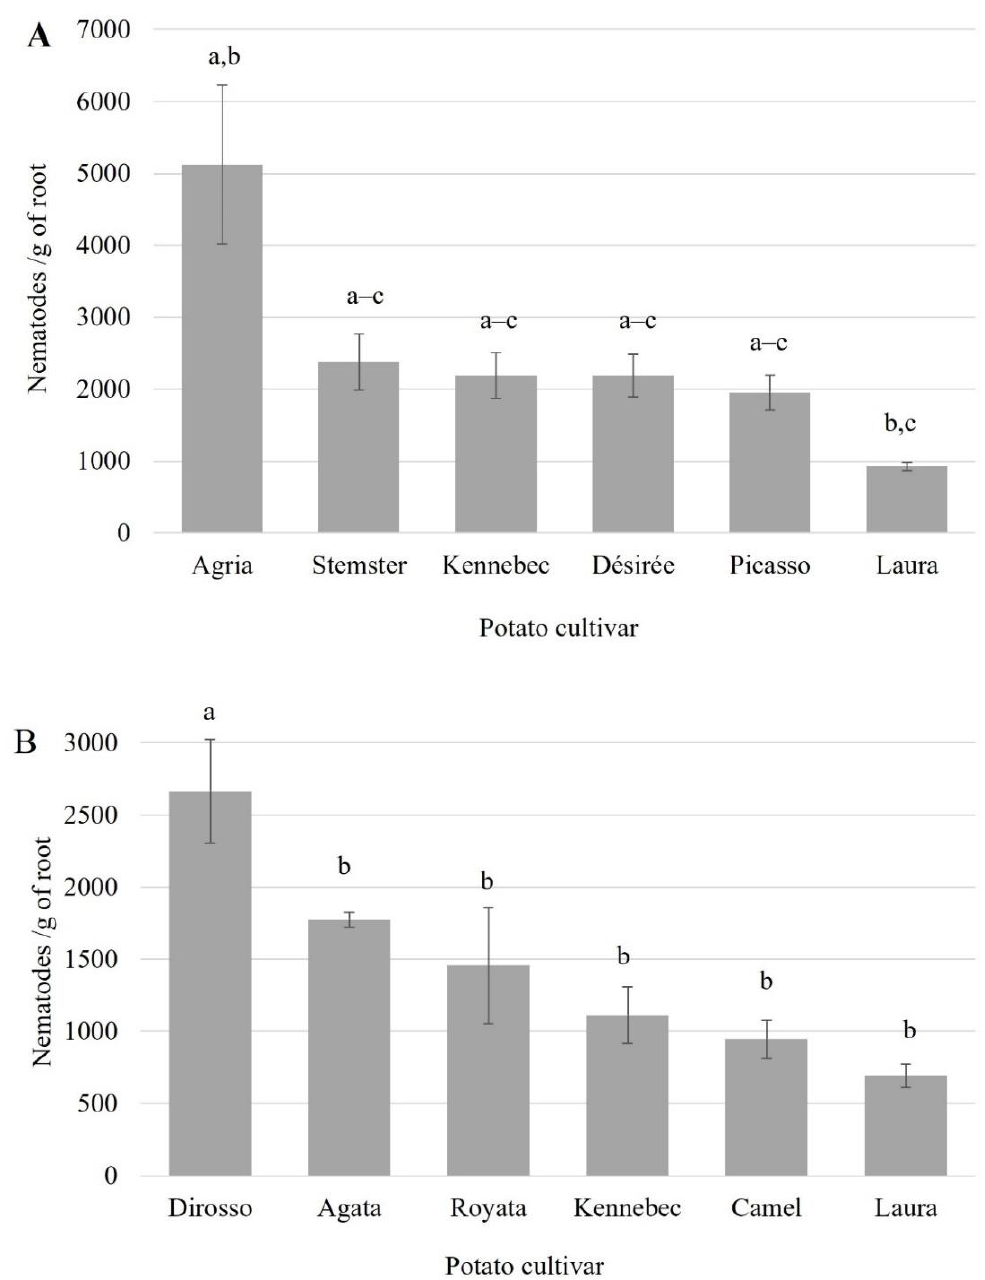
Figure 7. Nematodes/g of root on potato, Solanum tuberosum , cultivars: ( A ) Agria, Stemster, Kennebc, Désirée, Picasso, and Laura (Assay 1); ( B ) Dirosso, Agata, Royata, Kennebec, Camel, and Laura (Assay 2), 60 days after inoculation with 8000 Pratylenchus penetrans mixed stages. Data are the means of six replicates ± standard error. Means followed by a different combination of letters differ significantly at p < 0.05, according to the Fisher LSD test.